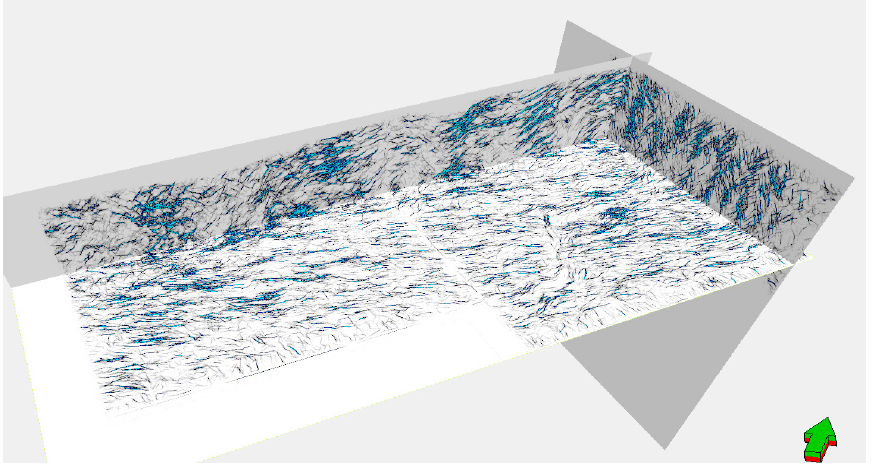
Figure 4. Ant-tracking model extracted from seismic body.